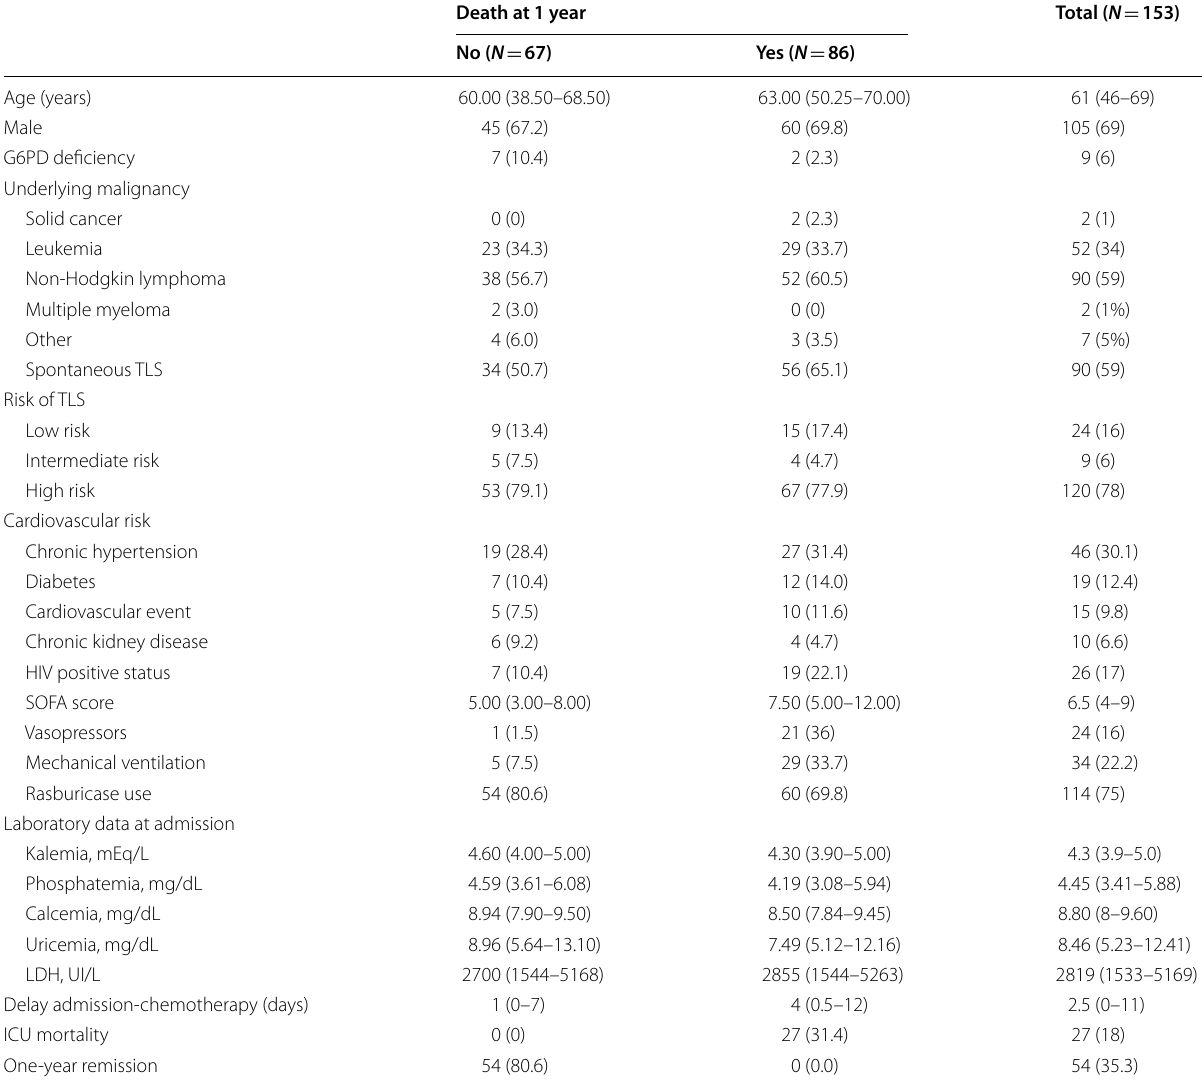
Table 1 Demographics details, clinical data, and laboratory data. Results are reported as n (%) or median